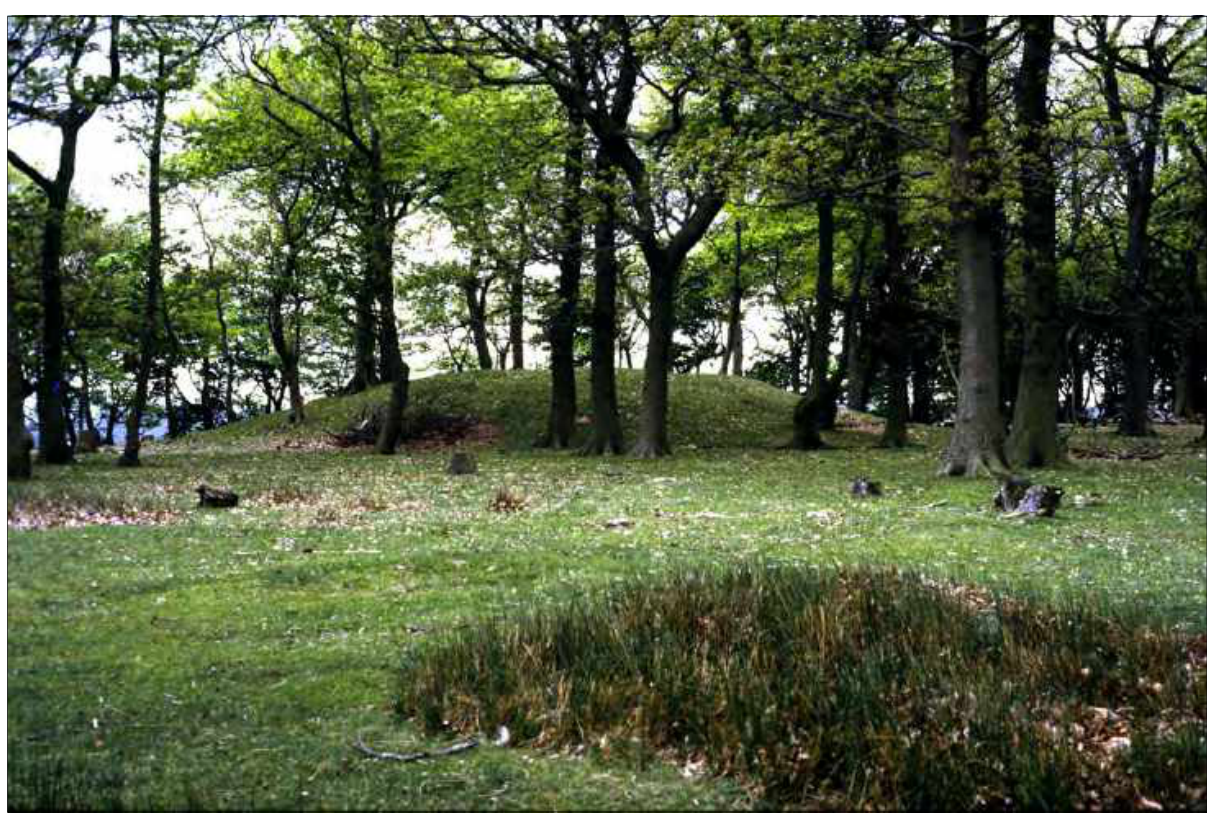
Fig 2.20 Bronze Age barrow at Brownlow, near Mellor, Greater Manchester